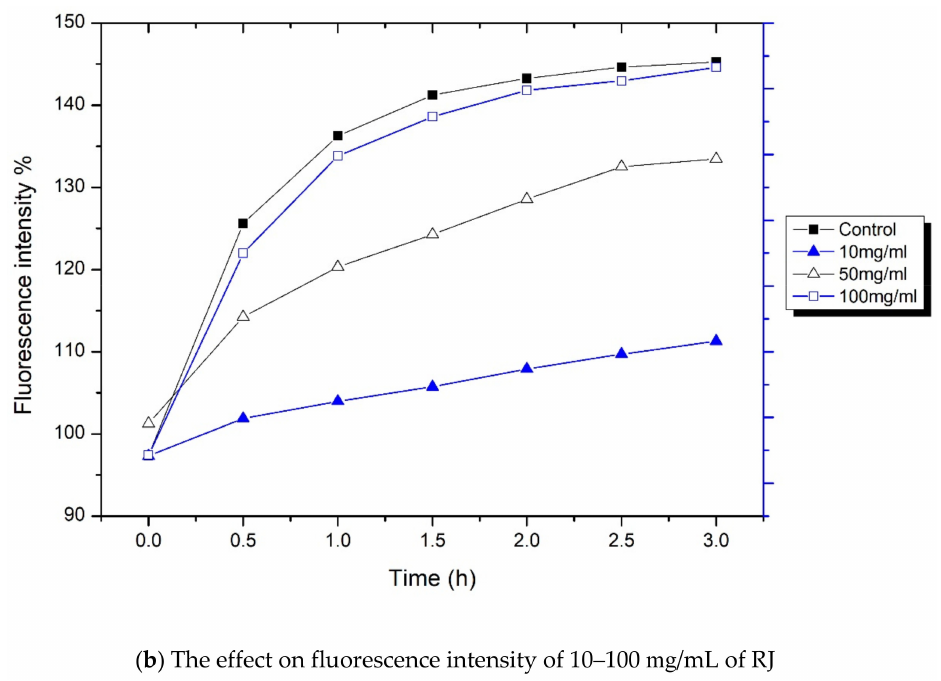
Figure 6. Effects of different concentrations of 10-HDA ( a ) and royal jelly ( b ) on intracellular reactive oxygen species (ROS) generation in SIRC cells ( n = 5). Data are presented as means of percentage of control fluorecence ± SE. 3D dry eye model results are indicated in Figure 7.